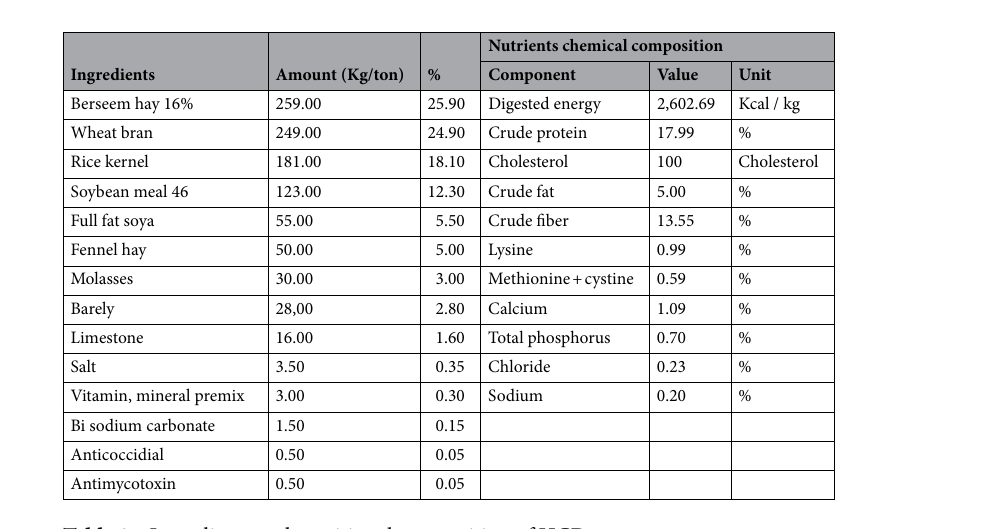
Table 2. Ingredients and nutritional composition of